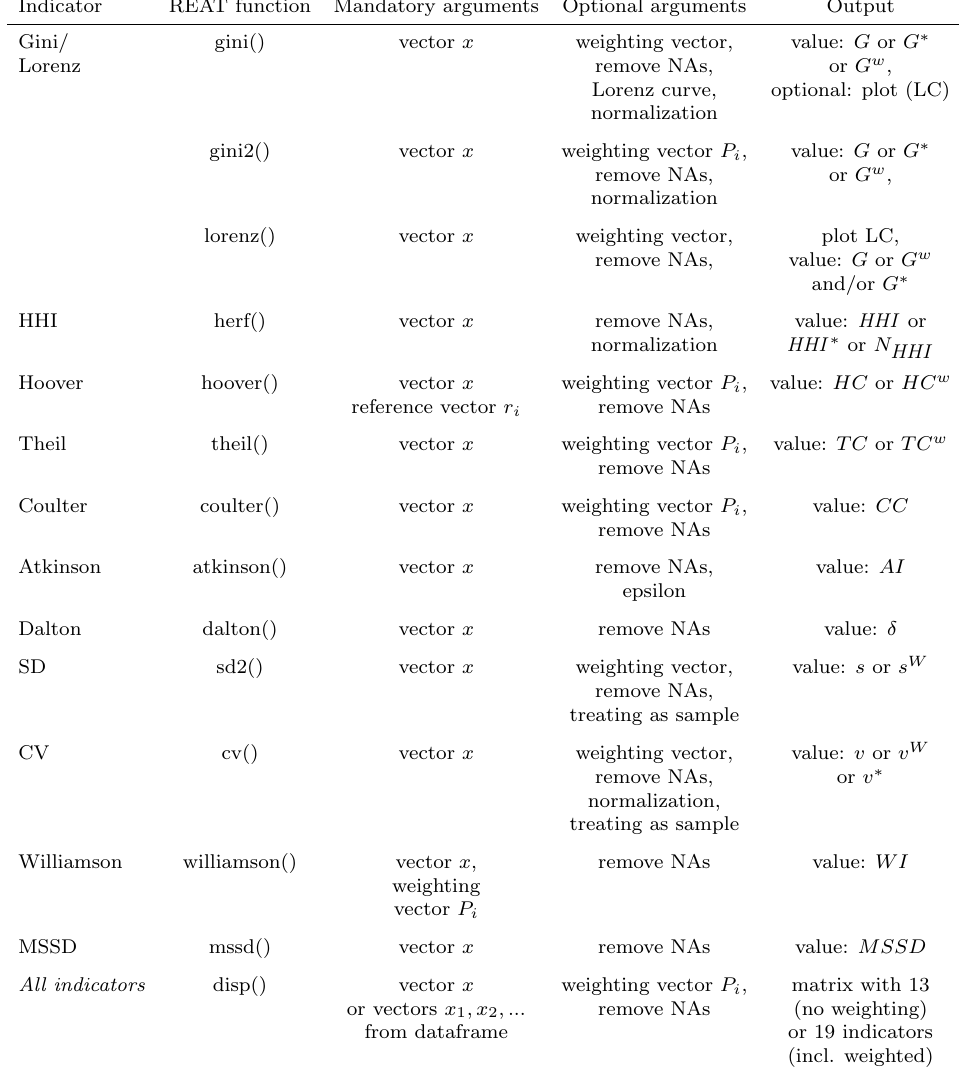
Table 2: REAT functions for concentration and dispersion indicators